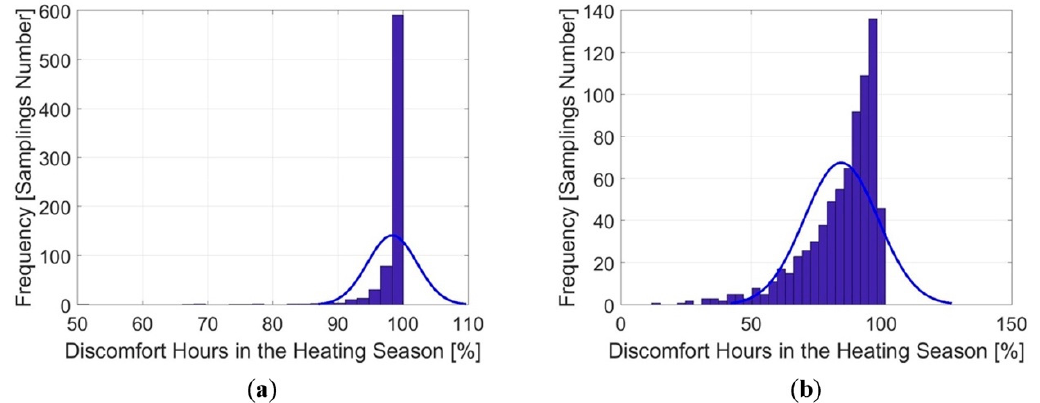
Figure 5. Distribution of DH h values in the building category. Winter period (December–February): ( a ) under typical climatic conditions; ( b ) for the 2050 climate scenario.